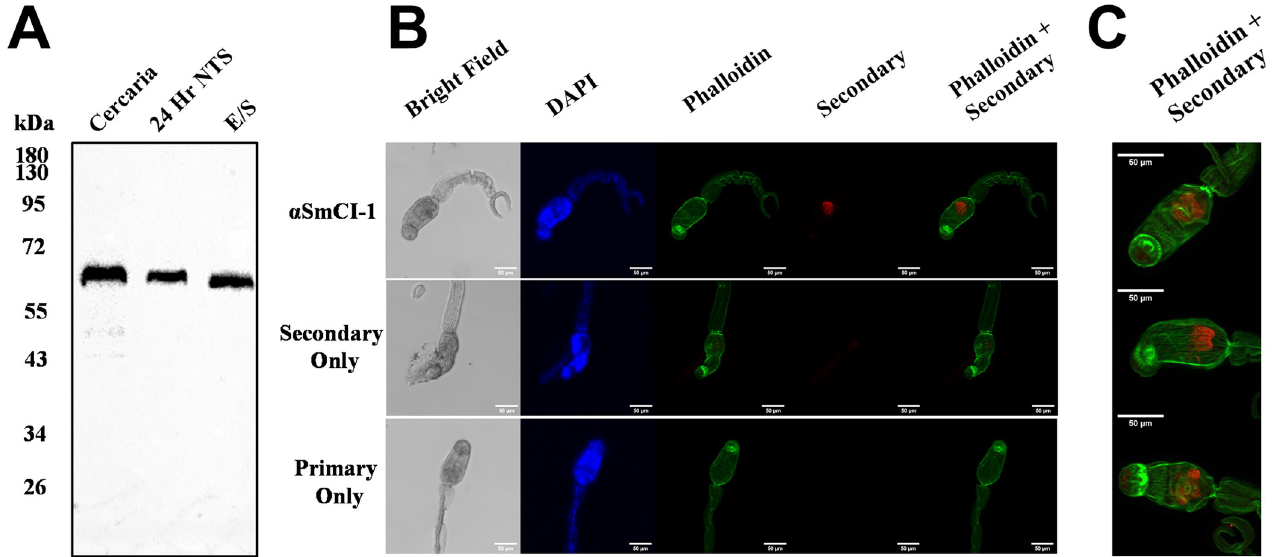
Fig 1. (A) Western blot showing SmCI-1 immunoreactivity as a ~65kda band in cercaria, 24 hour post transformation cercaria, and cercarial E/S products. (B) SmCI-1 is detected within the S . mansoni cercaria, in an area consistent with localization within the acetabular glands, as revealed by immunofluorescence imaging, with SmCI-1 signal appearing in red. (C) Additional immunofluorescence images feature varying levels of fluorescence with consistent localization within the